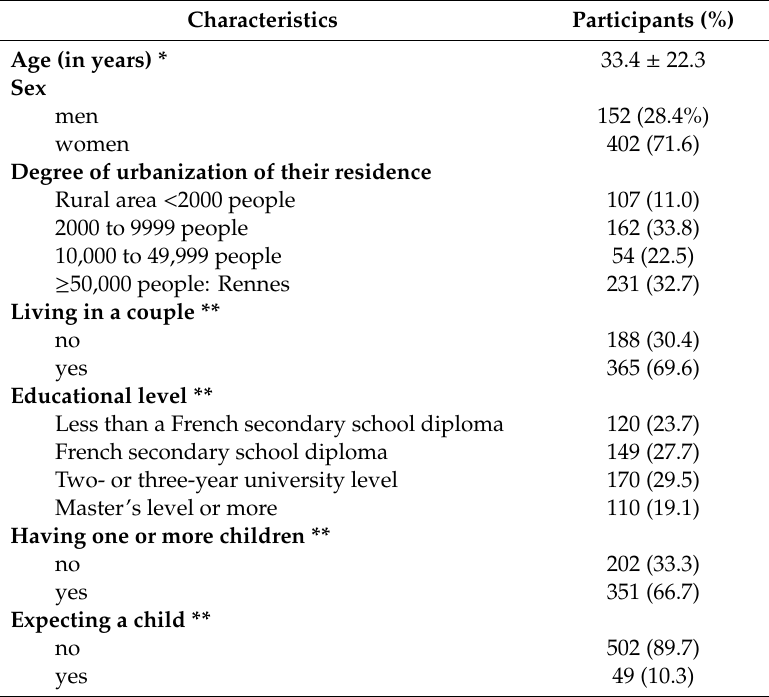
Table 1. Population characteristics ( n =